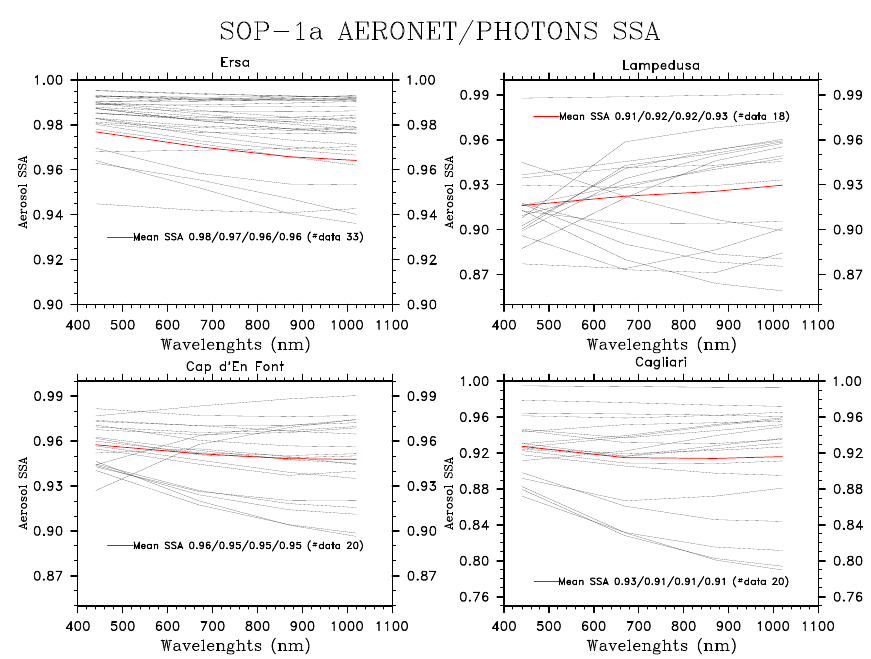
Figure 20. AERONET/PHOTONS observations (Ersa, Lampedusa, Cap d’En Font and Cagliari) of the total single scattering albedo (SSA) at 440, 670, 880 and 1020nm obtained for the whole SOP-1a period (the red curve represents the mean of